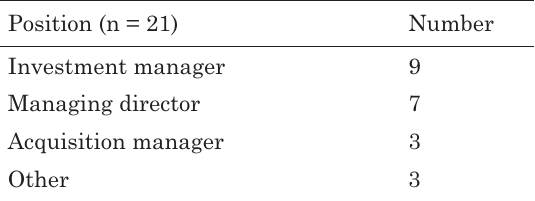
Table 1. Respondents by their position